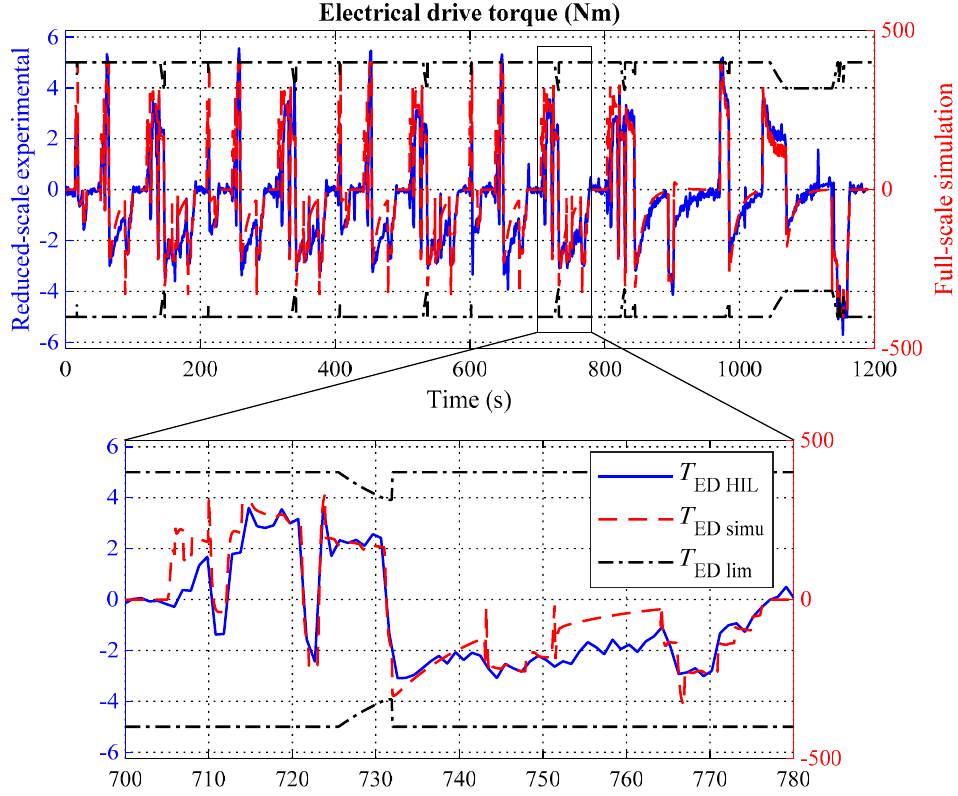
Figure 13. (Experimental) electrical drive torque obtained by the proposed LQR-based strategy with NEDC.